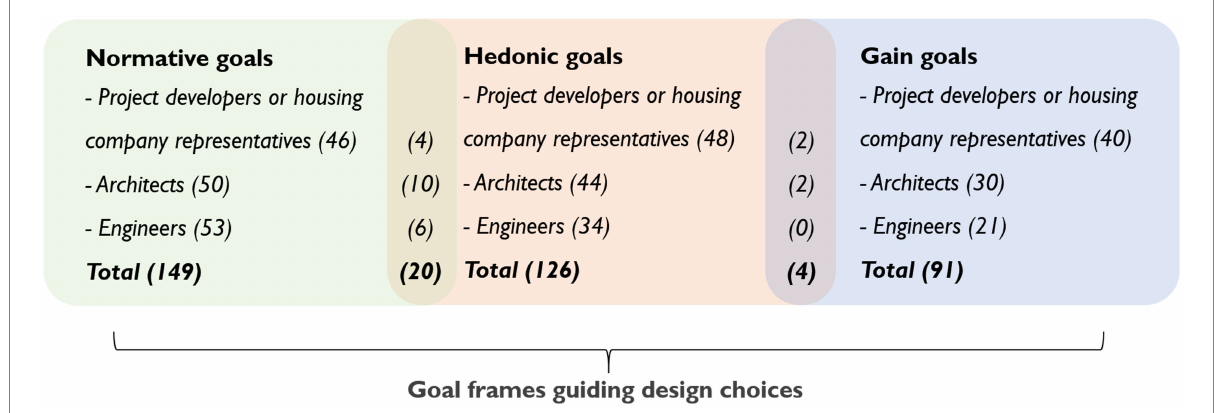
FIGURE 1 Numerical information indicates the frequency with which the participants expressed the goals. Note: overlaps were identified between hedonic and normative goals, and between hedonic and gain